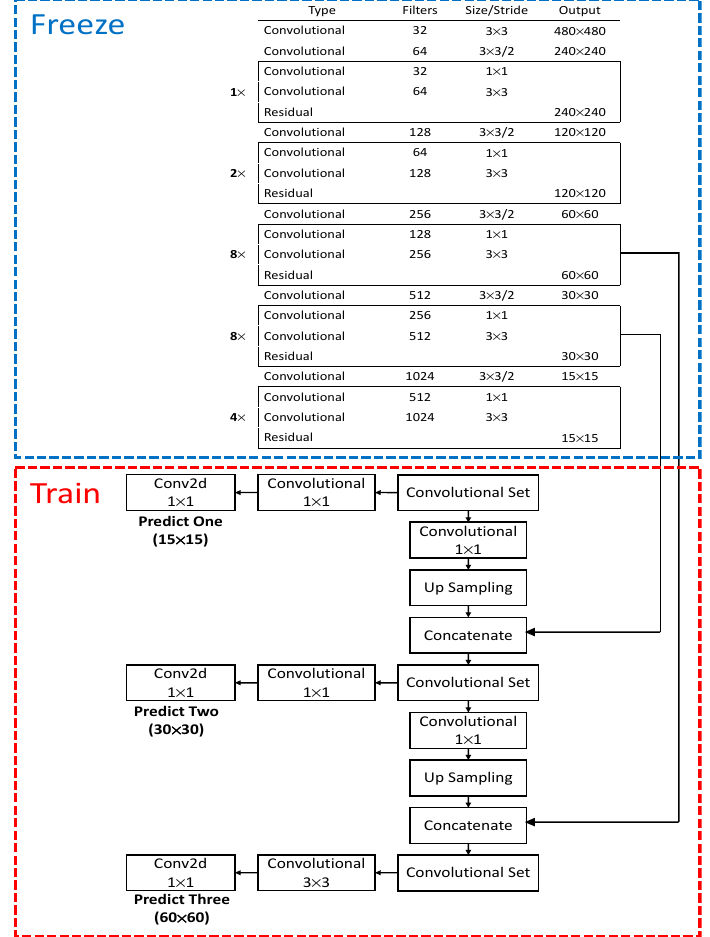
Figure 7. Steps of the incremental learning method.